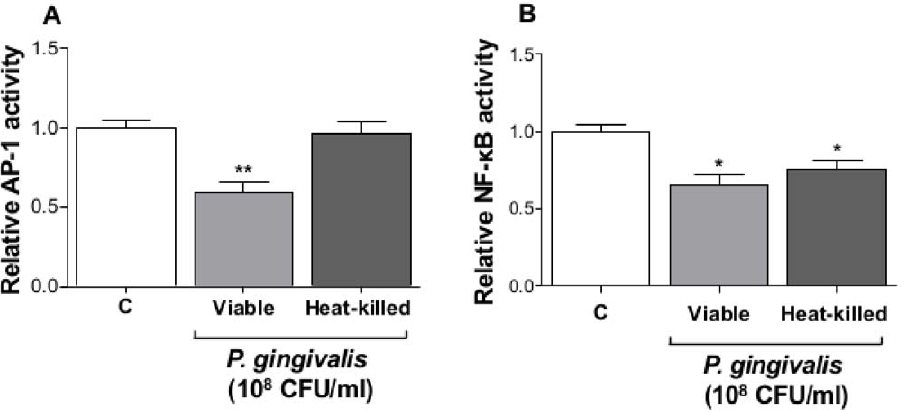
Figure 3. P.gingivalis suppressed AP-1 and NF- k B activity. Jurkat T-cells (10 6 cells/ml) were transfected with either AP-1 ( A ) or NF- k B ( B ) luciferase reporter plasmids. The cells were treated with viable or heat-killed P. gingivalis (10 8 CFU/ml, MOI:100) for 24 h. AP-1 and NF- k B activation were determined by measuring luciferase activity, which was normalized against the internal control Renilla . *-p , 0.05; **-p , 0.01 (Student’s t -test).